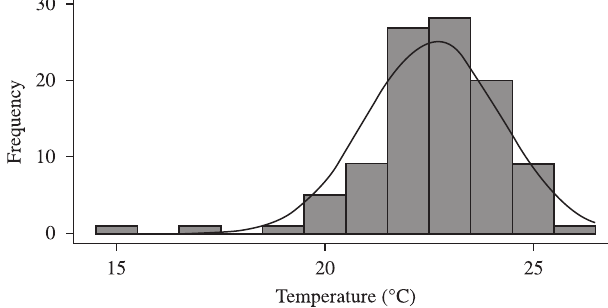
Figure 5. Absolute frequency histogram of the average temperatures for the cities of São Paulo State.